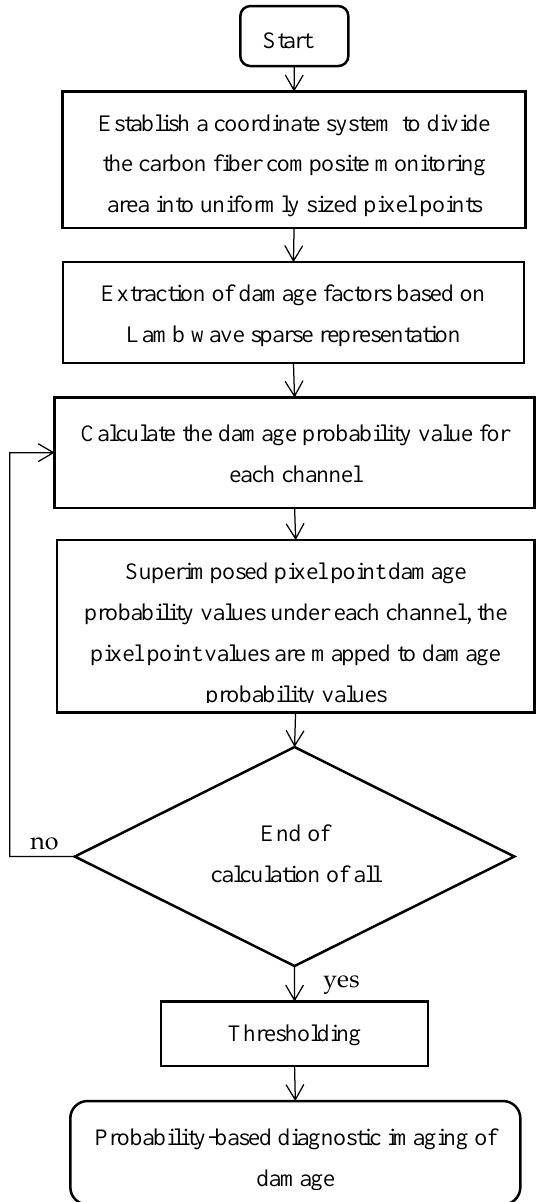
Figure 3. Flow chart of damage probability imaging algorithm based on Lamb wave damage factor.